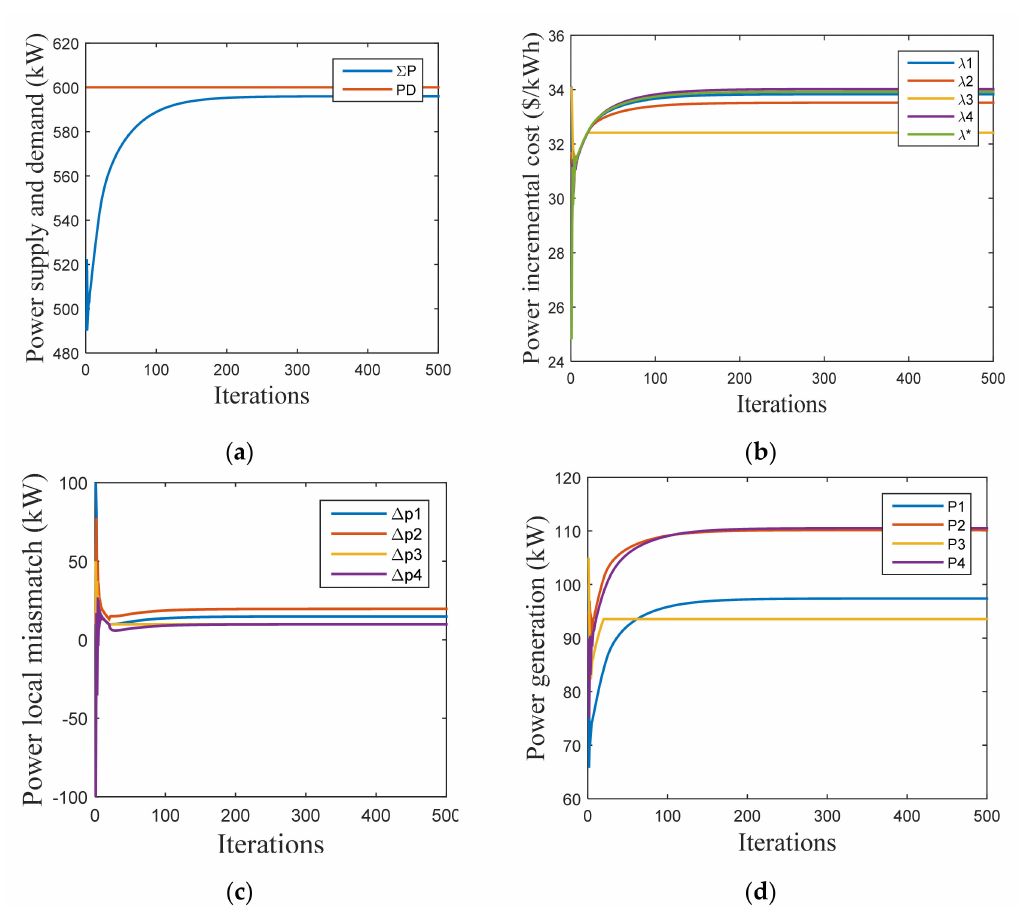
Figure 11. The process of economic dispatch under the colluding attacks; they should be listed as: ( a ) Total system power output; ( b ) Incremental cost; ( c ) Estimated local power mismatch; ( d ) Output